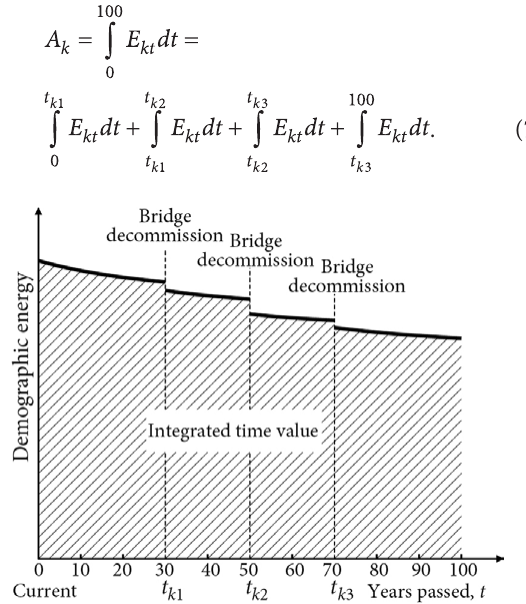
Fig. 4. Bridge decommission and demographic